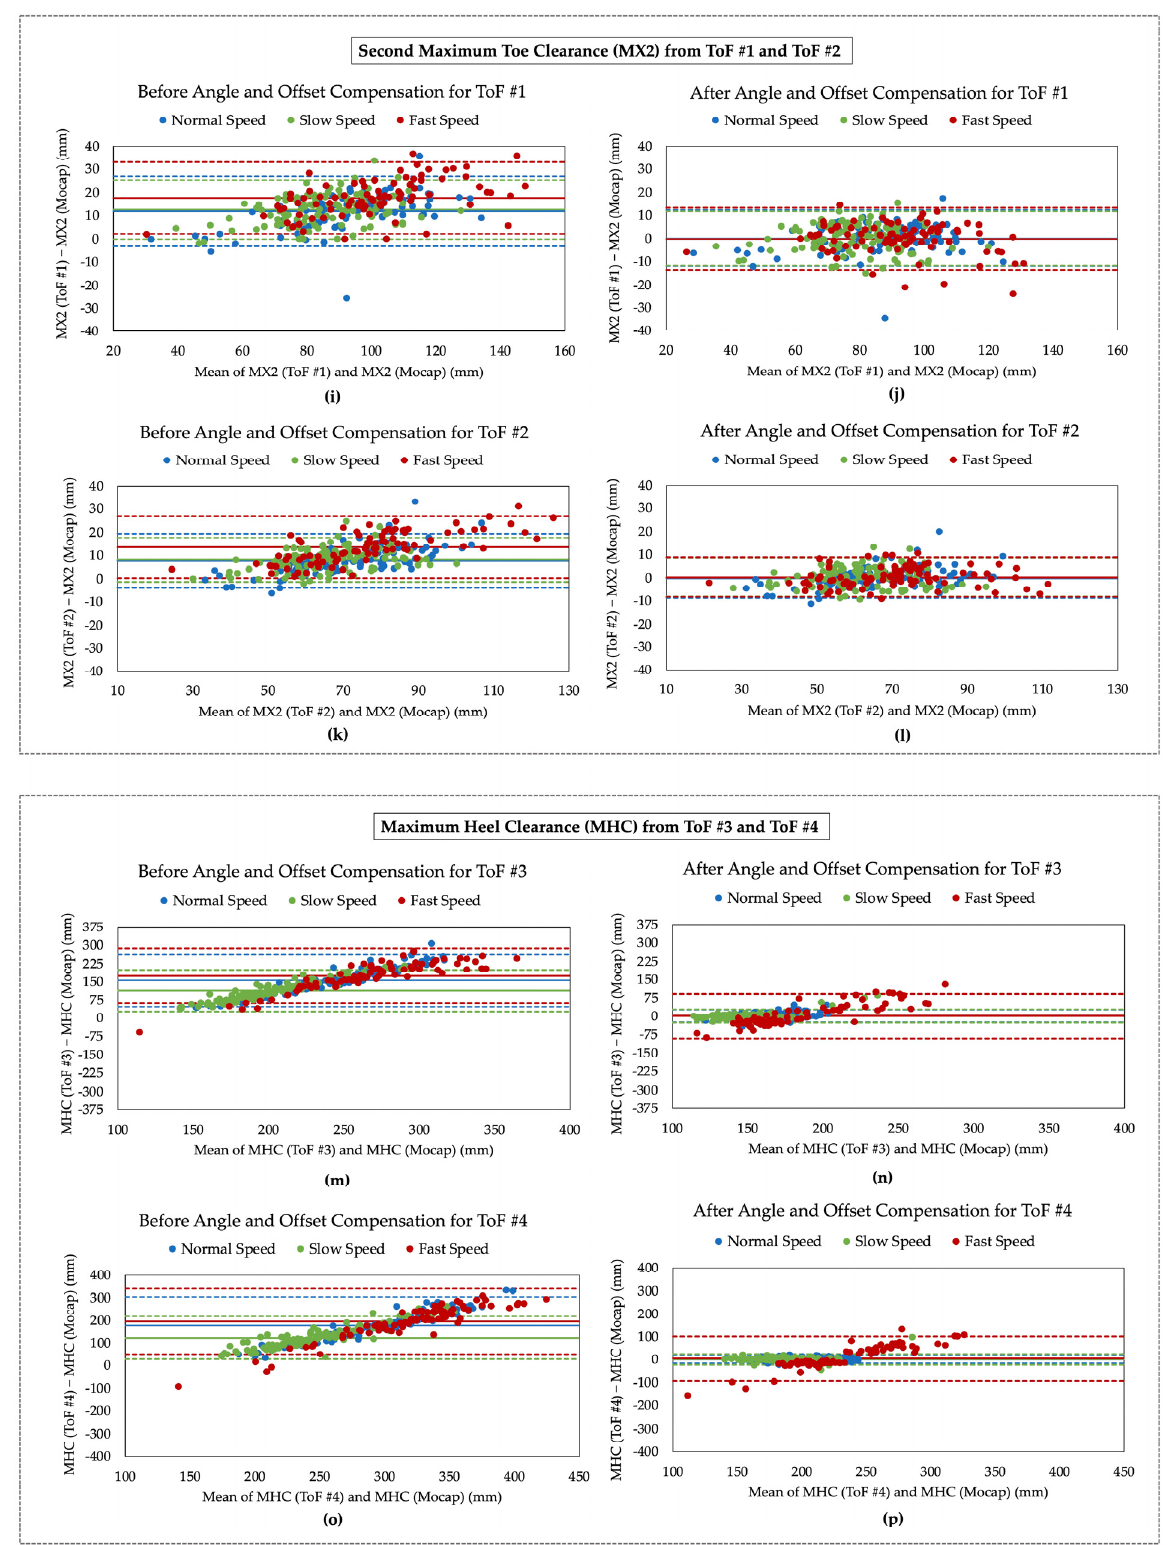
Figure 8. Bland-Altman plots for estimated gait parameters before and after angle and offset compensation for ( a – d ) Mini- mum Toe Clearance (MTC), ( e – h ) First Maximum Toe Clearance (MX1), ( i – l ) Second Maximum Toe Clearance (MX2) and ( m – p ) Maximum Heel Clearance (MHC) for normal, slow, and fast walking speed. The solid lines and dash lines represent the bias and limits of agreement (LOA) (Mean ± 1.96 SD), respectively.